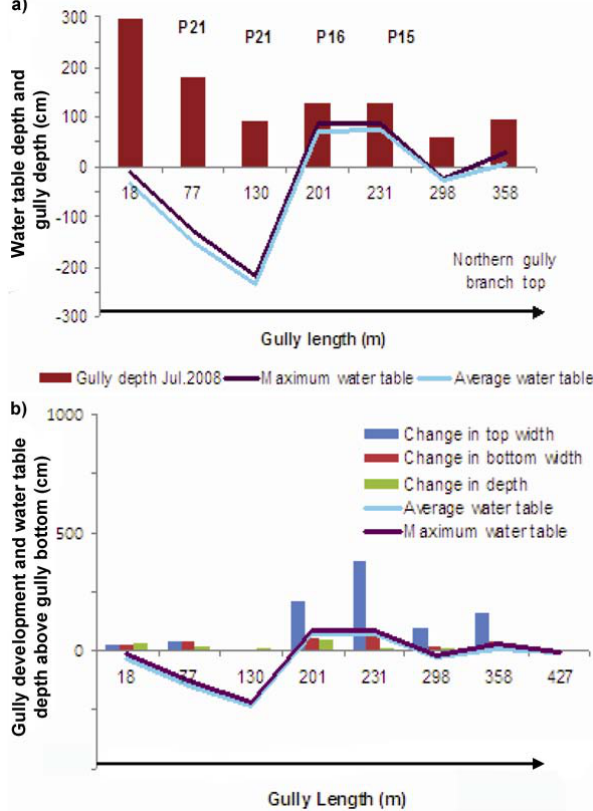
Fig. 7. (a) Gully dimensions before and after the 2008 rainy season for the northern gully branch A (note the gully bottom is the refer- ence elevation) and (b) depths and average ground water table and change in top and bottom width and depth of the